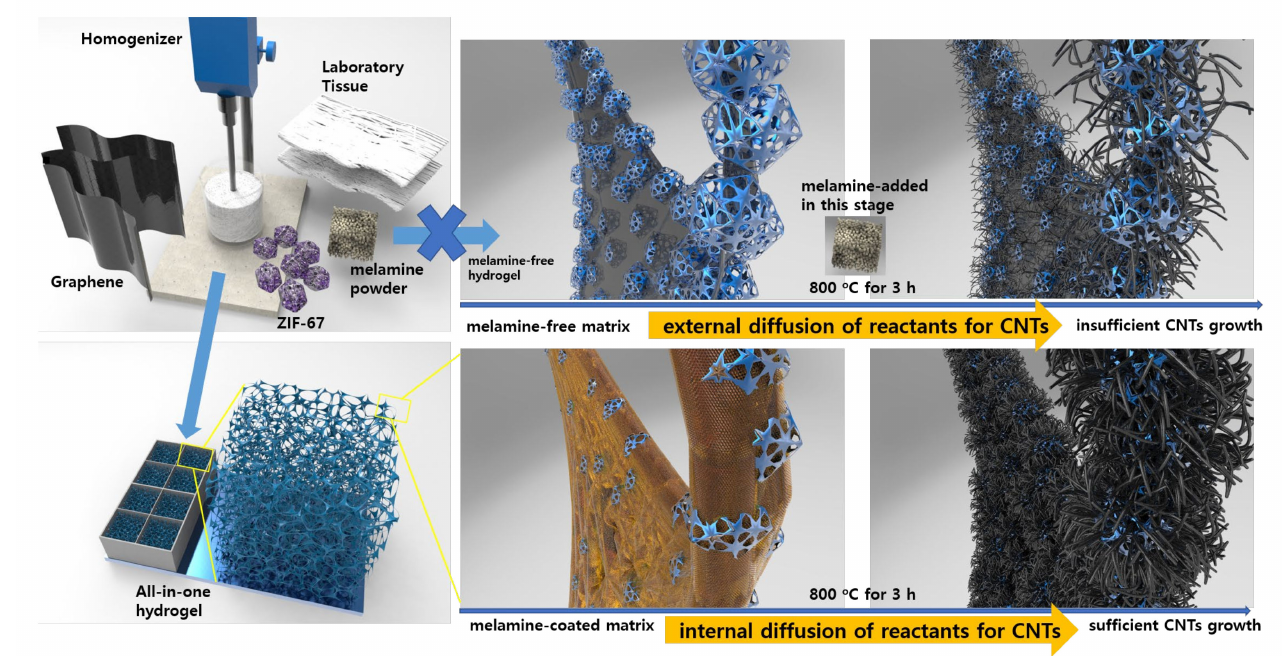
Figure 1. Schematic illustration of the synthetic process from an all-in-one hydrogel solution to a carbon aerogel sponge